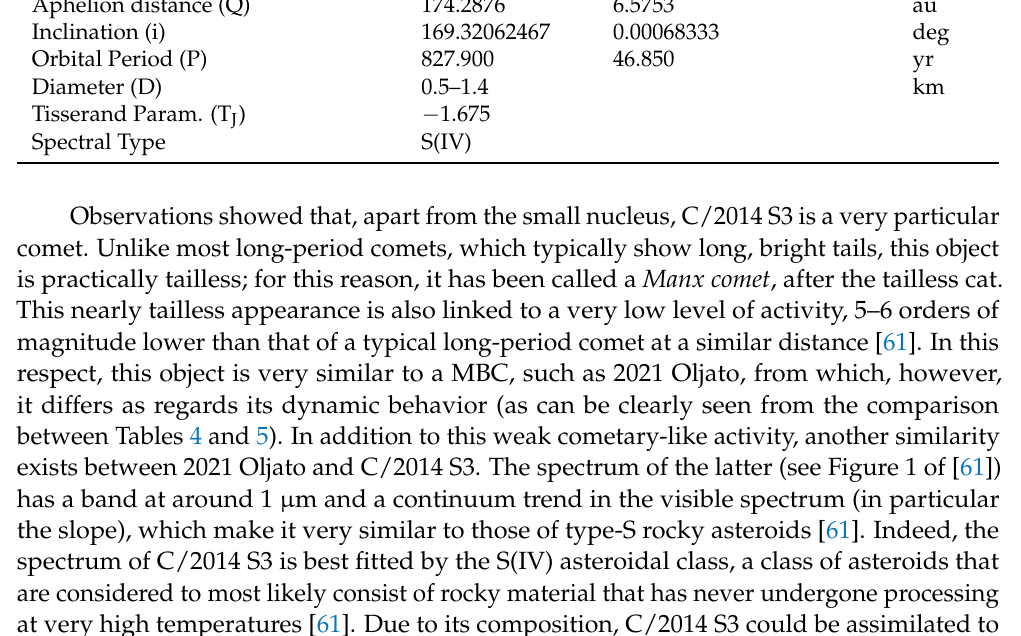
Table 5. Physical characteristics of the comet C/2014 S3 (Pan-STARRS). Data taken from the NASA/JPL Small-Body Database site and from Meech et al. [61]. Parameter Value Uncertainty (1-Sigma) Units Eccentricity (e) 0.97675738 0.00087411 Semi-major axis (a) 88.1684 3.3263 au Perihelion distance (q) 2.04926524 0.00024291 au Aphelion distance (Q) 174.2876 6.5753 au Inclination (i) 169.32062467 deg Orbital Period (P) 827.900 46.850 Diameter (D) 0.5–1.4 km Tisserand Param. (T J ) − 1.675 Spectral Type